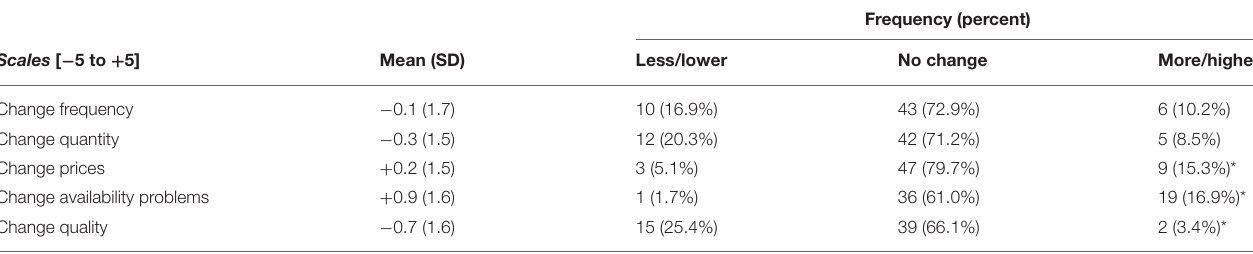
Frequency (percent)